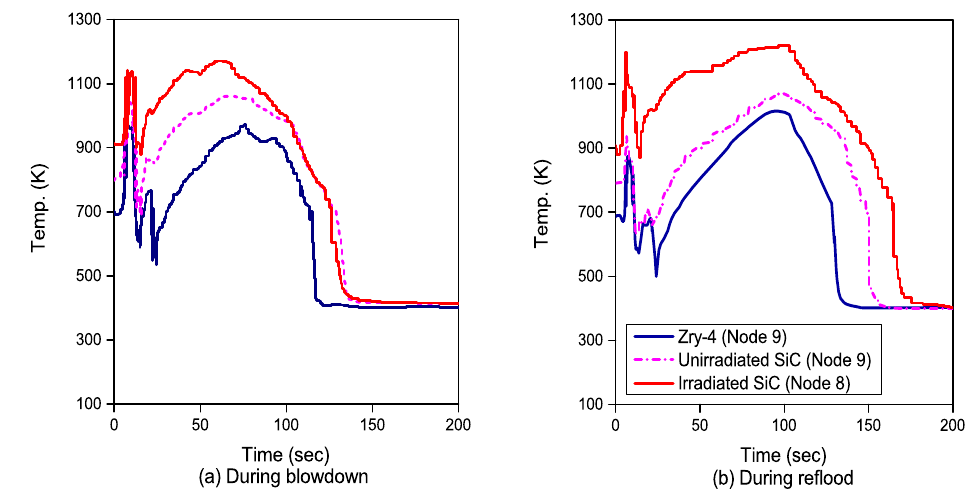
Figure 5. Inner peak cladding